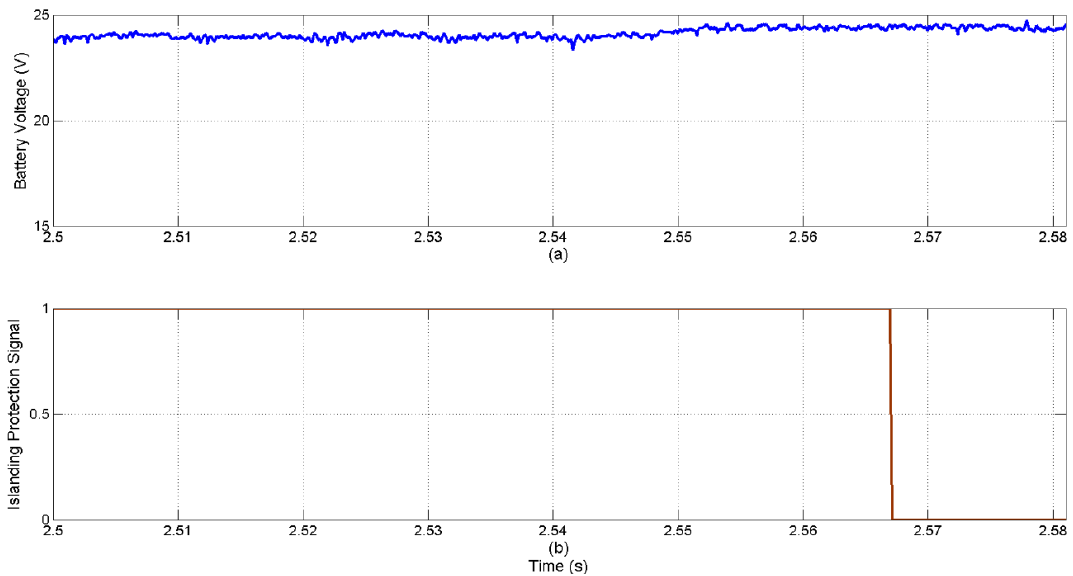
Figure 18. Change of the battery voltage when the power grid is powered up again. ( a ) Battery voltage [V] ( b ) Islanding protection signal.